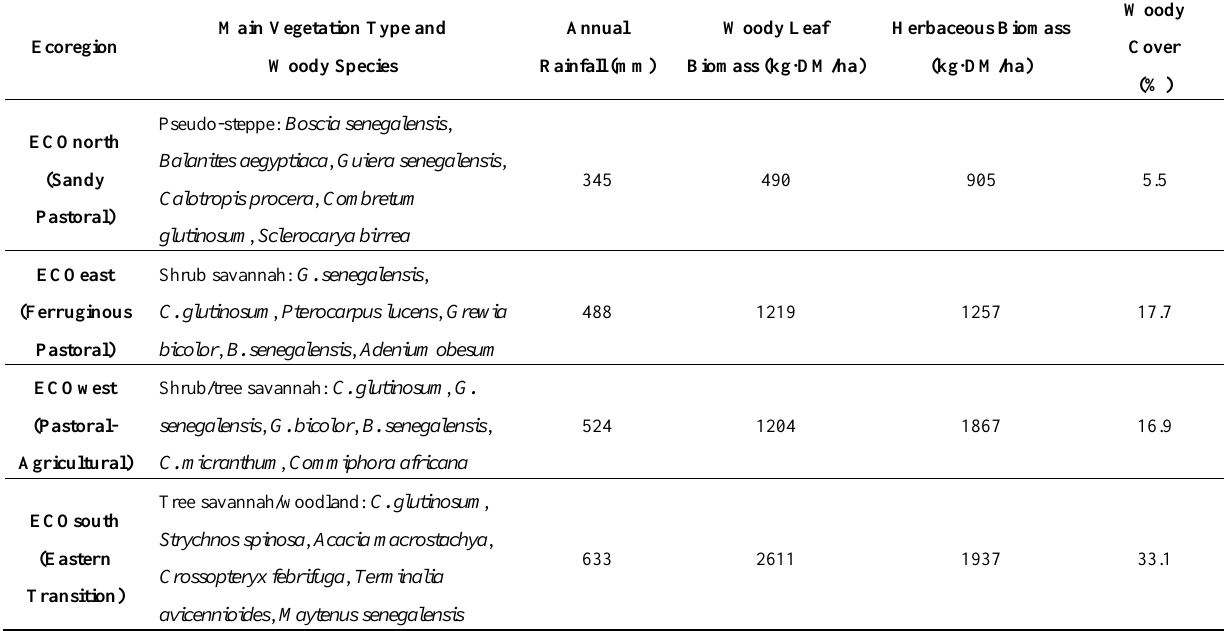
Table 1. Description of ecoregions: vegetation type and main woody species, annual rainfall (based on average values of RFE of FEWS Net data for the period 1999–2013), biomass, and woody cover based on ground measurements (1999–2013). The values for rainfall, woody leaf biomass, herbaceous biomass, and woody cover correspond to the average from sites in each